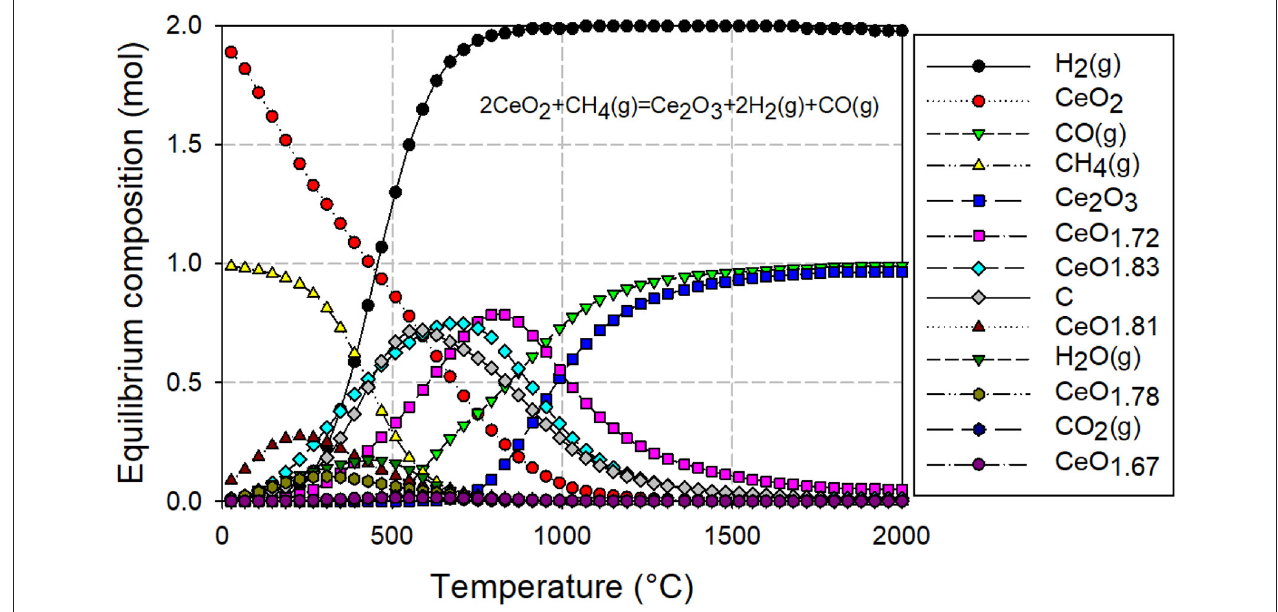
FIGURE 5 | Thermodynamic equilibrium composition of ceria reduction with methane as a function of temperature at 1